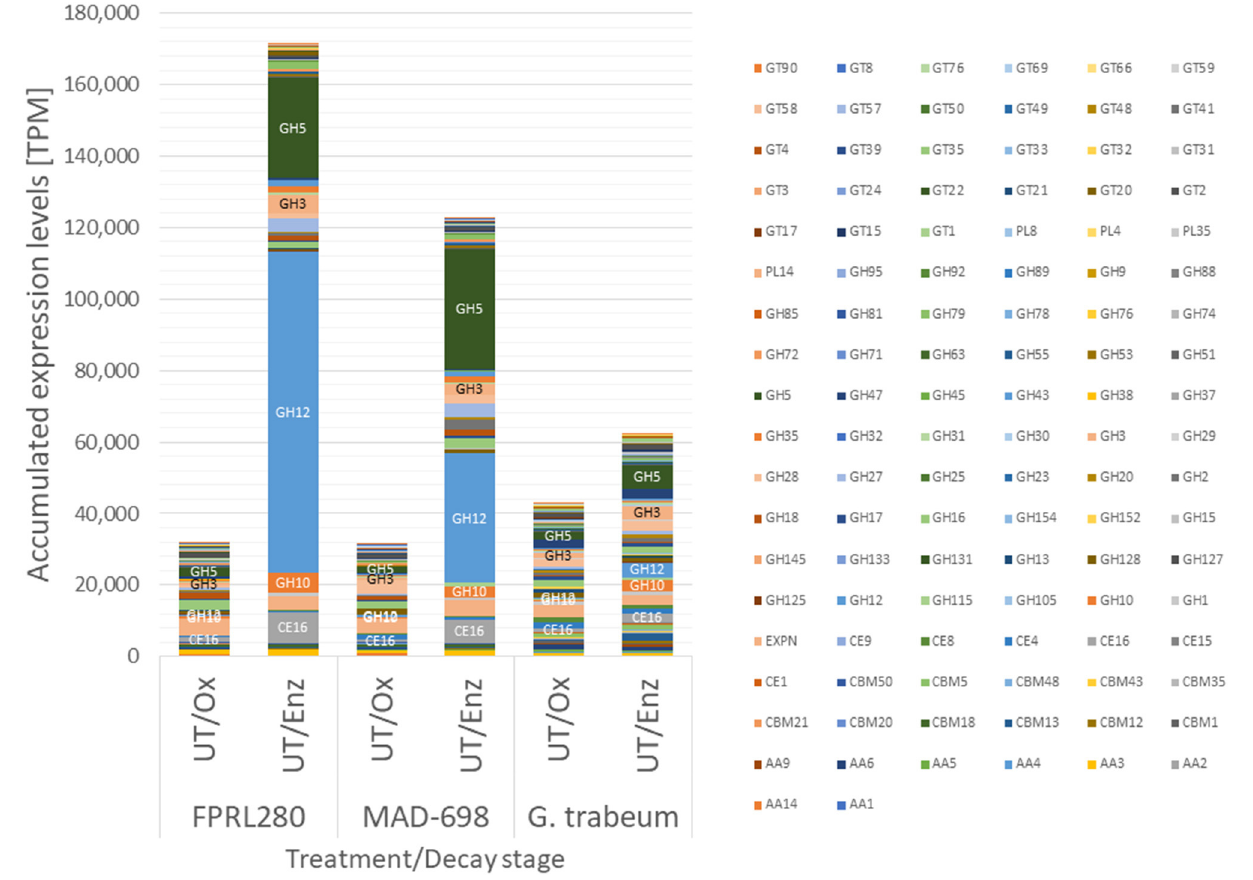
FIGURE 3 | Accumulated expression values [transcripts per million (TPM)] for all CAZy families in strains of R. placenta and G. trabeum showing the differences between the strains and the decay stages. The largest bar of FPRL280/UT/Enz and MAD-698/UT/Enz is the GH12 family. The second larger group represents the CAZy family GH5. More detailed graphics on the single CAZy families are shown in Supplementary Figures 3A–F